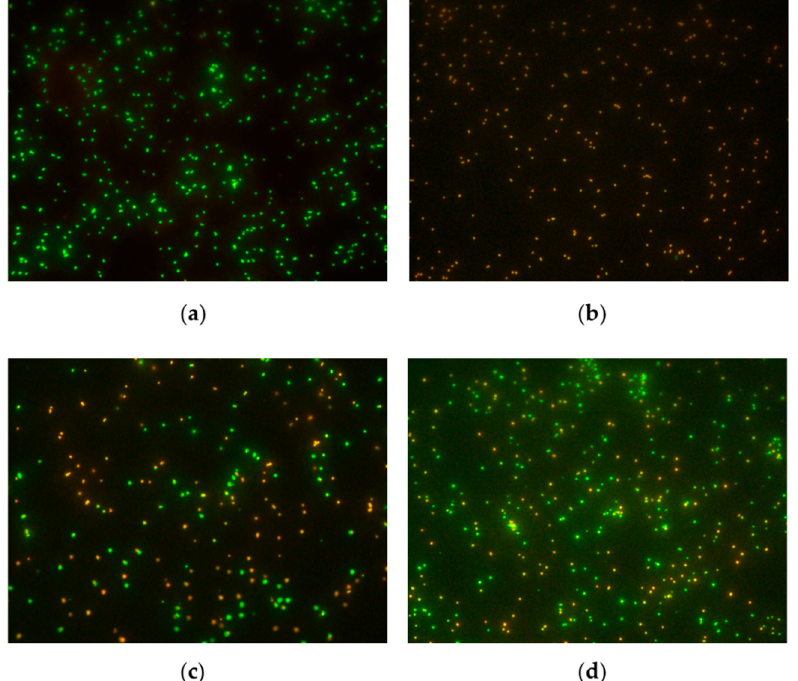
Figure 2. Examples of viable (green) and dead (red) bacteria ( S. epidermidis DSM 3269) visualized using fluorescence microscopy: ( a ) suspension of live bacteria; ( b ) suspension of dead bacteria; ( c ) suspension of induced VBNC bacteria by gentamycin at 4 × MIC; ( d ) suspension of induced VBNC bacteria by gentamycin at 16 × MIC. Magnification, ×600.